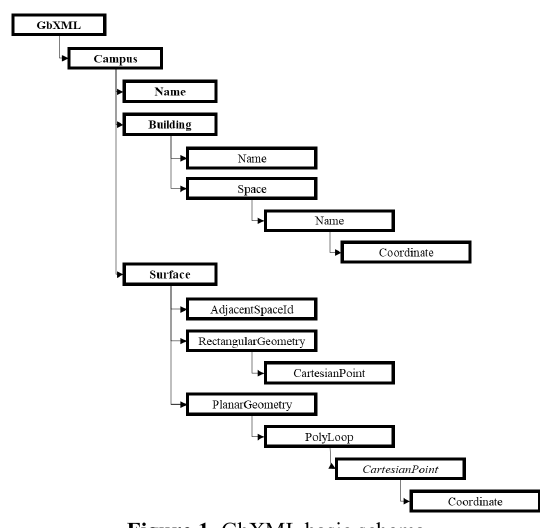
Figure 1. GbXML basic schema